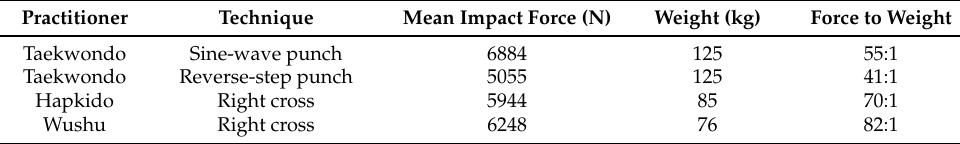
Table 5. Martial arts punching techniques mean force to weight ratio